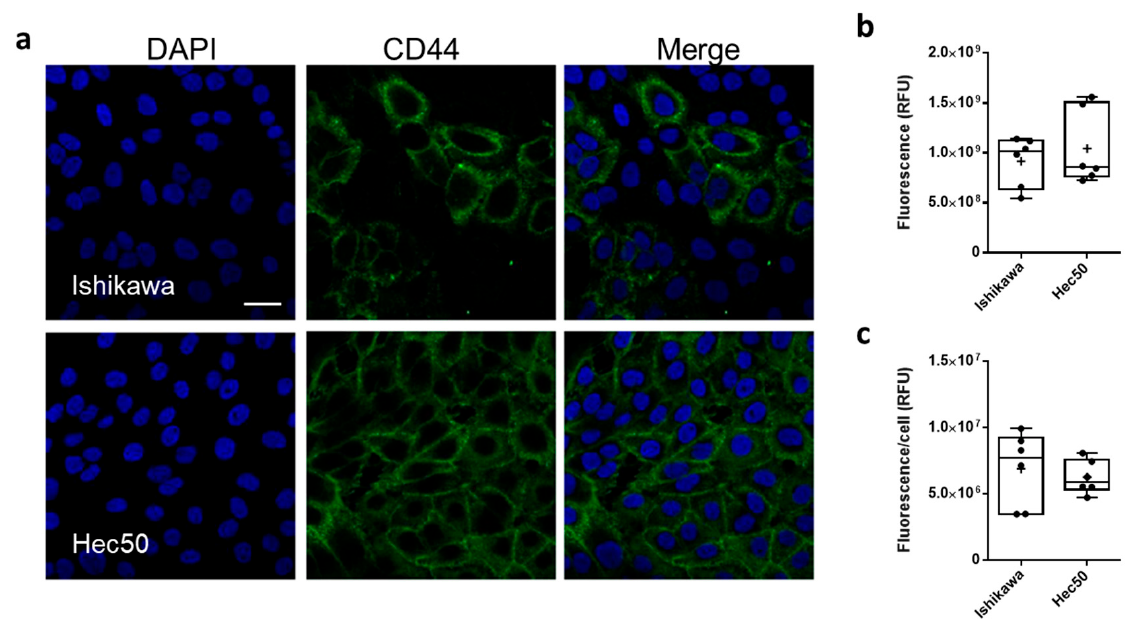
Figure 2. CD44 expression in endometrial cancer models. Representative immunofluorescence images showing CD44 expression (FITC, green) in Ishikawa and Hec50 cells ( a ) nuclei where stained with DAPI (blue), scale bar is 30 µ m. Relative fluorescence units (RFU) values obtained from ImageJ analysis of immunofluorescence images ( b ), RFU per cell based on nuclei count ( c ) where each point plotted is value from each field analyzed.